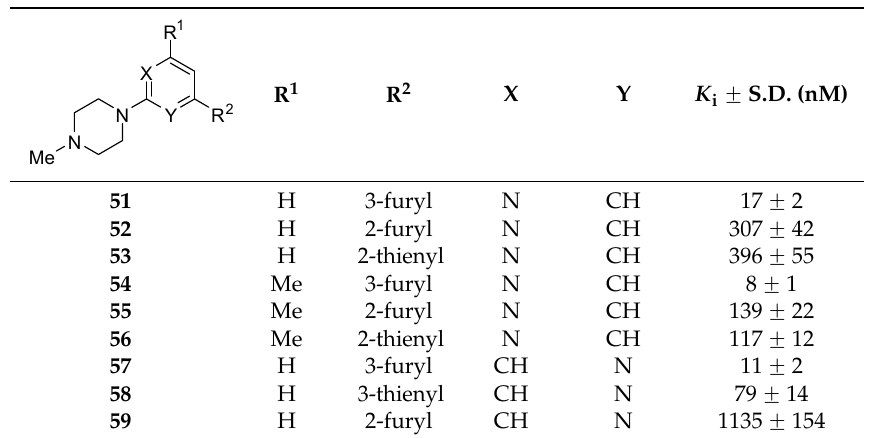
Molecules 2016 , 21 , 433 8 of 21 position 6 ( 59 K i = 1135 nM) of the pyridine as the attachment site. The pyridine ligands incorporating 3-thienyl ( 58 K i = 79 nM) and 2-thienyl ( 53 K i = 396 nM) substituents are nearly equipotent compared to